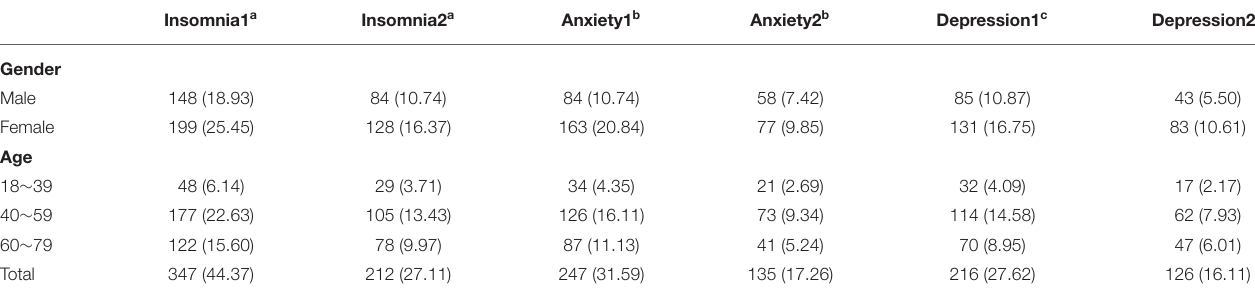
TABLE 2 | Prevalence (%) of insomnia, anxiety, and depressive symptoms among the discharged COVID-19 patients across gender and age groups. Insomnia1 a Insomnia2 a Anxiety1 b Anxiety2 b Depression1 c Depression2 c